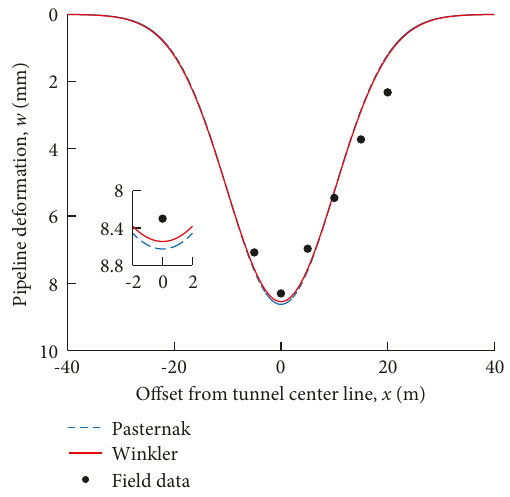
Figure 5: Comparison of analytical solution against field data.